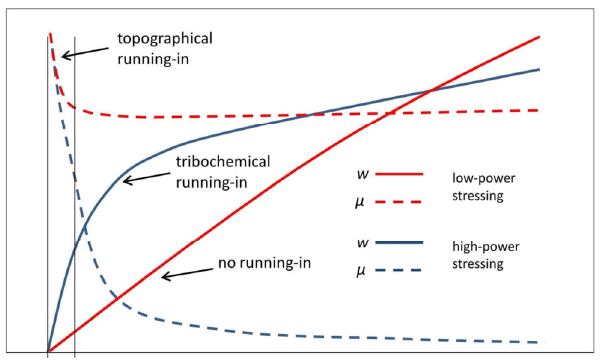
Fig. 31 An illustrative depiction of the changes in friction coefficient  and cumulative wear W during running-in (horizontal axis) under low-power or high-power stressing [352]. Reproduced with permission from Ref. [352], © The authors,